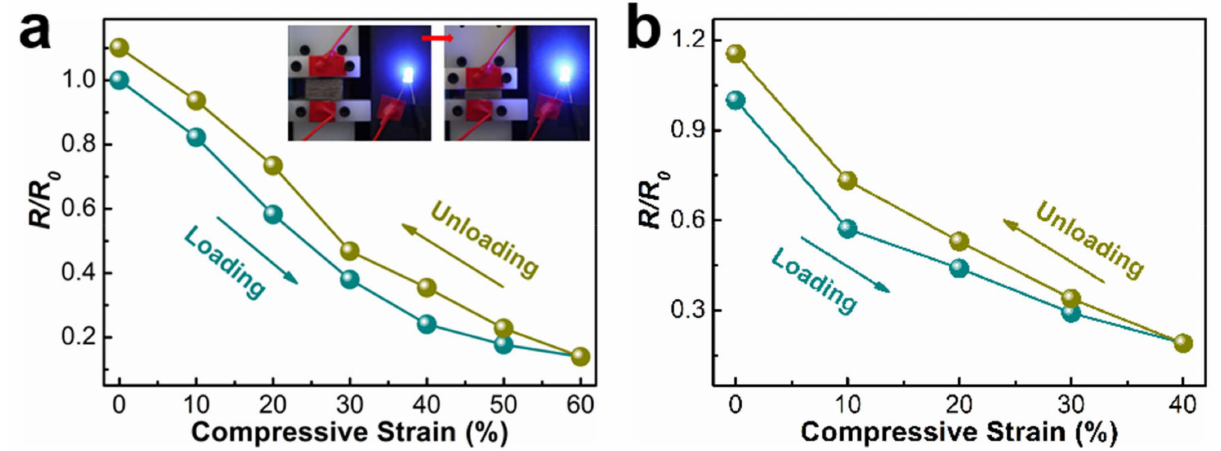
Figure 7. Normalized resistances of Ni-PW at different compression strain for the ( a ) first and ( b ) 1000th cycles. The insets in panel ( a ) show the brightness increases of blue LED on compression of the Ni-PW.